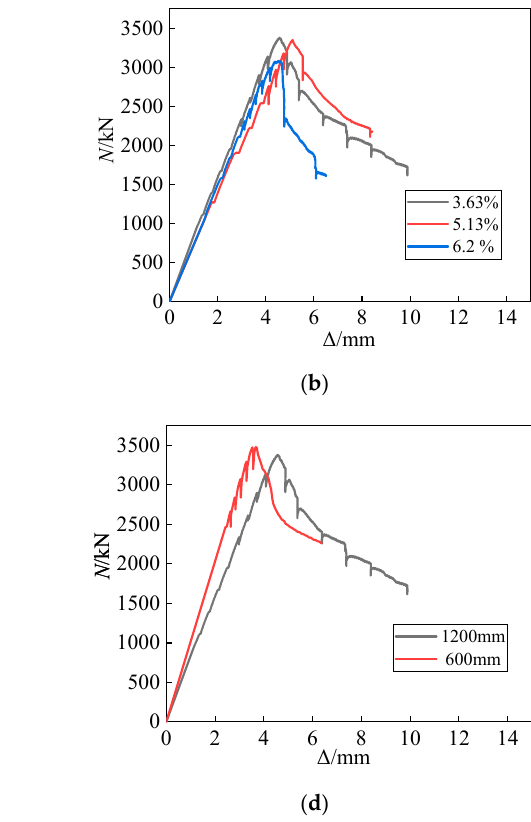
Figure 8. The load–displacement curves of the SRHC columns at various ( a ) concrete strengths, ( b ) steel contents, ( c ) eccentric distances, and ( d ) slenderness ratios.